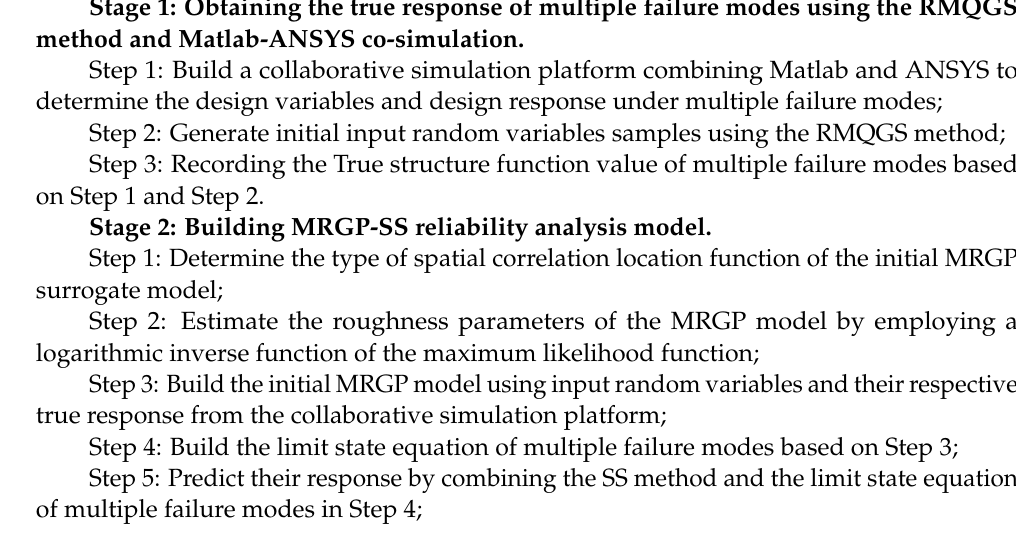
Figure 3. Scatter plot of different sampling methods. ( a ) LHS; ( b ) RGS; ( c ) RMQGS.